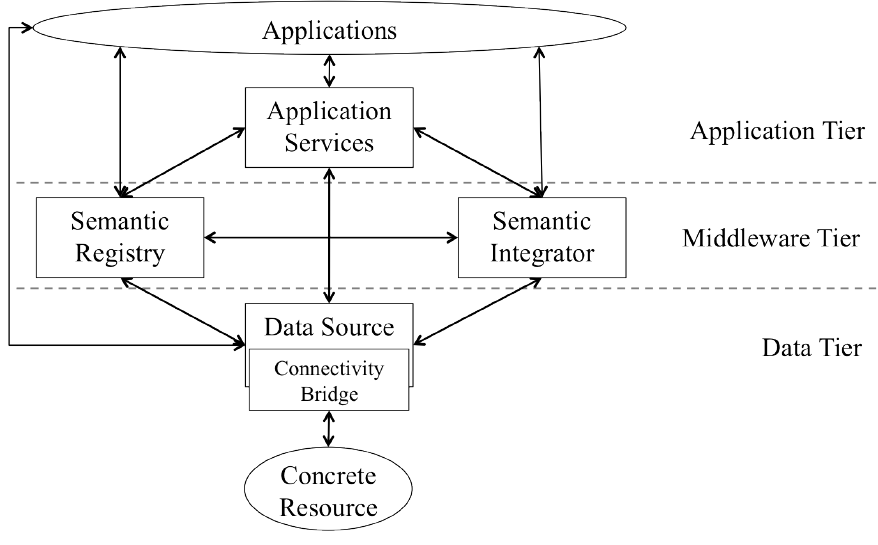
Figure 2. The service types, and their interactions, that form a semantic sensor web. Note that the Data Source service type collectively represents the three types of data service (see Section 4.2).